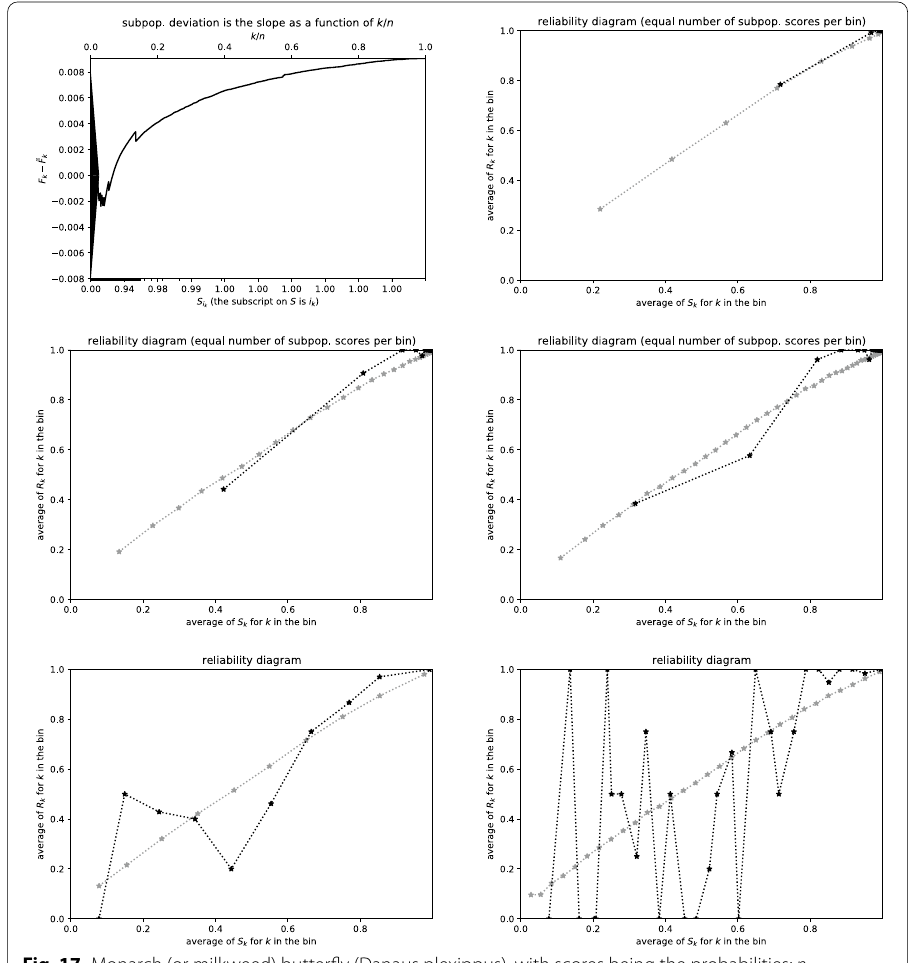
Fig. 17 Monarch (or milkweed) butterfly (Danaus plexippus), with scores being the probabilities; n